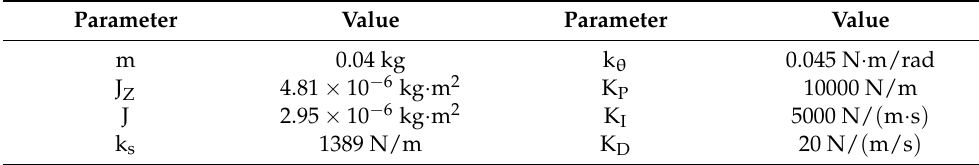
Table 3. System parameters relevant to the employed